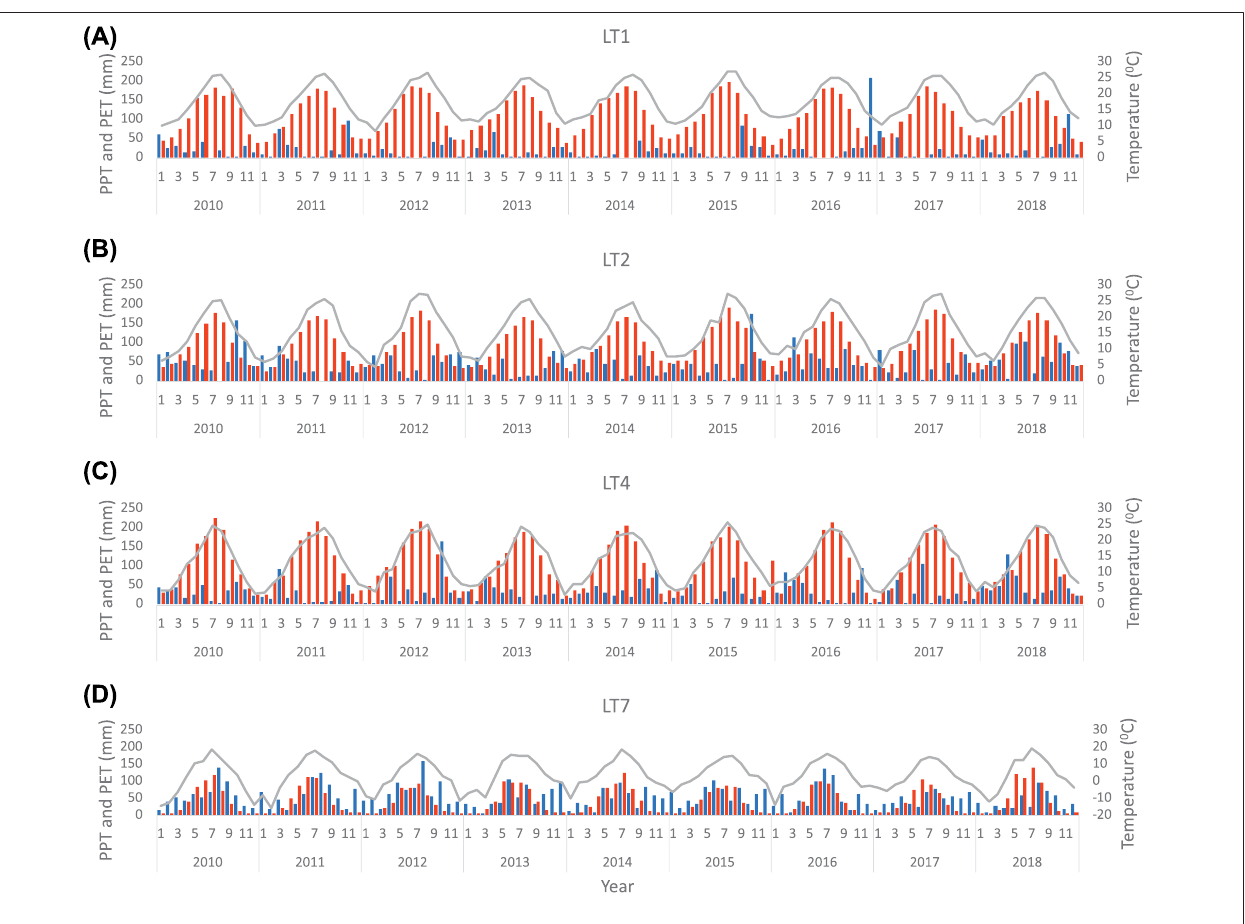
FIGURE1| Monthlyclimatic characteristicsofEuropeancroplandduringthe2010 – 2018period. (A) LT1MurciaSpain, (B) LT2FoggiaItaly, (C) LT3HuescaSpain and (D) LT7Toholampi,Finland[PPT,Precipitationmm,(bluebars);PET,Potentialevapotranspiration(mm,redbars),Temperature,Averagetemperature( ° C,grayline)].